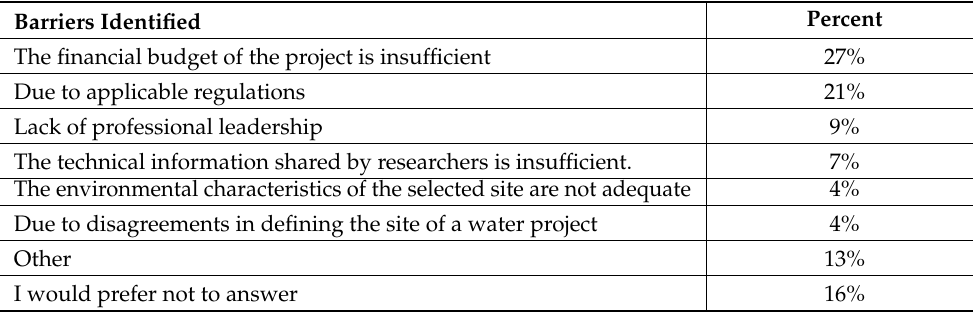
Table 3. Barriers that participants selected for building a collaborative relationship when working on water recharge projects (n =